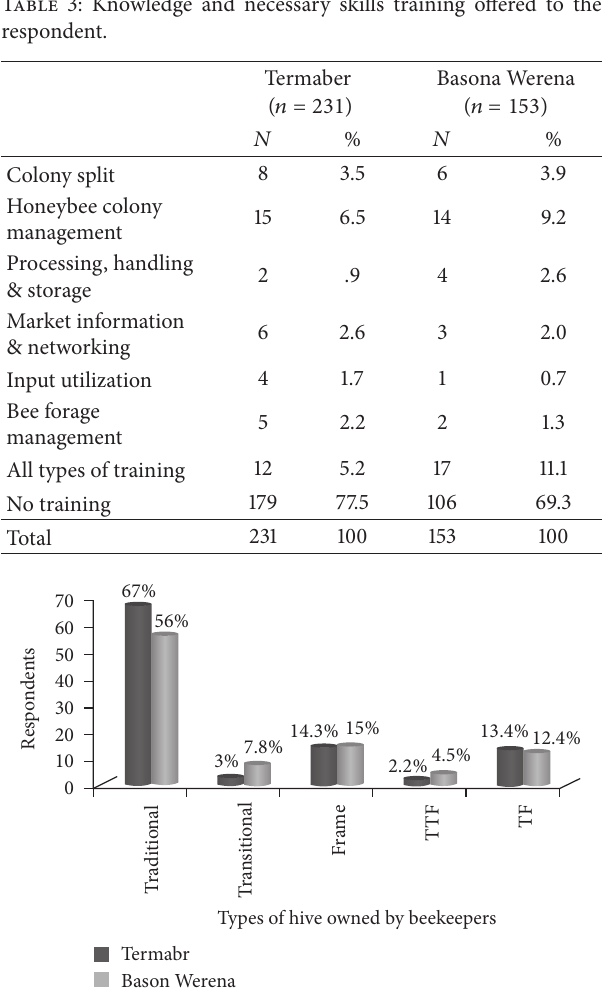
Figure 2: Hive ownership of beekeepers (TTF = Traditional, Transitional, and Frame; TF = Traditional and Frame).